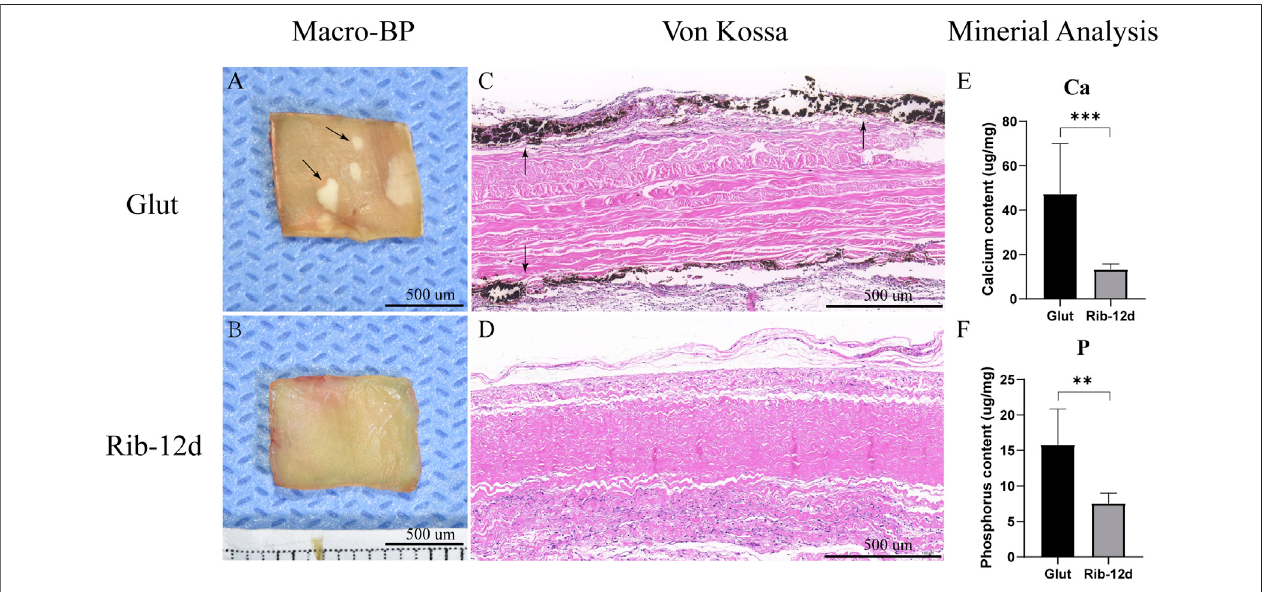
FIGURE12| Calci fi cation oftheBPpost-implantationintomalejuvenileratsfor90 days. (A,B) Macroimageofthecalcium nodules(black arrow). (C,D) vonKossa staining. Calci fi cation deposits were stained black (black arrow). (E,F) ICP-7400 quanti fi cation of calcium and phosphorus contents in Glut- or Rib-treated BP ( n = 12) (* p < 0.05, ** p < 0.01, and *** p < 0.001) Scale bars: 500